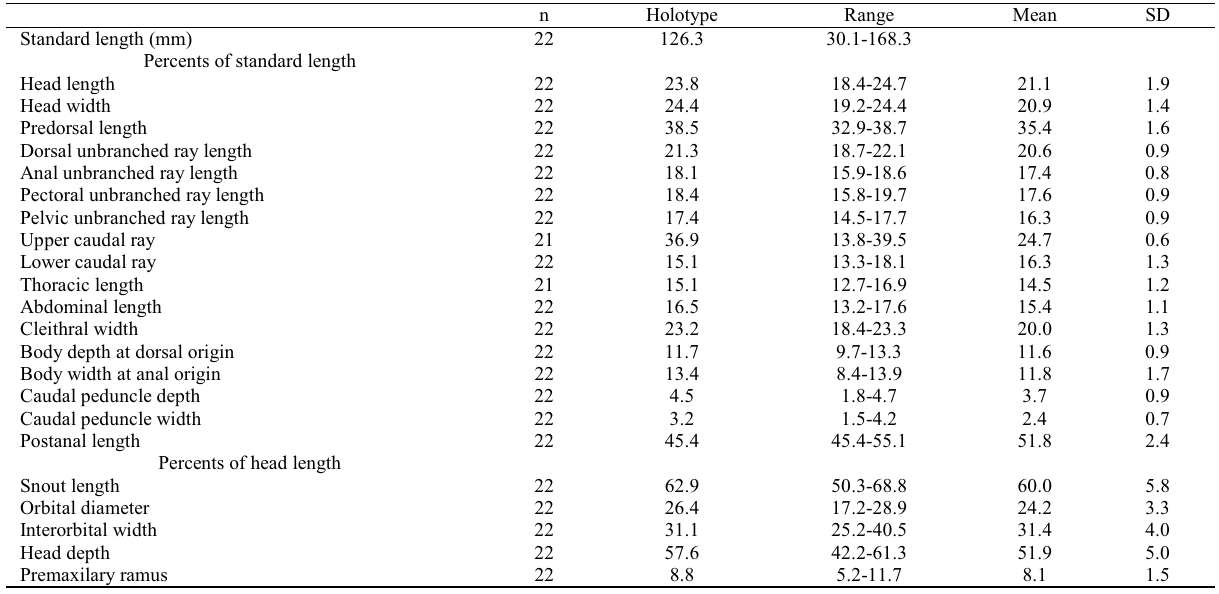
Fig. 4. Distribution of Rineloricaria osvaldoi . Pentagon = rio Vermelho (type locality); square = rio Table 1. Morphometric data of Rineloricaria osvaldoi (ranges include holotype; n: number of specimens, SD: standard deviation).